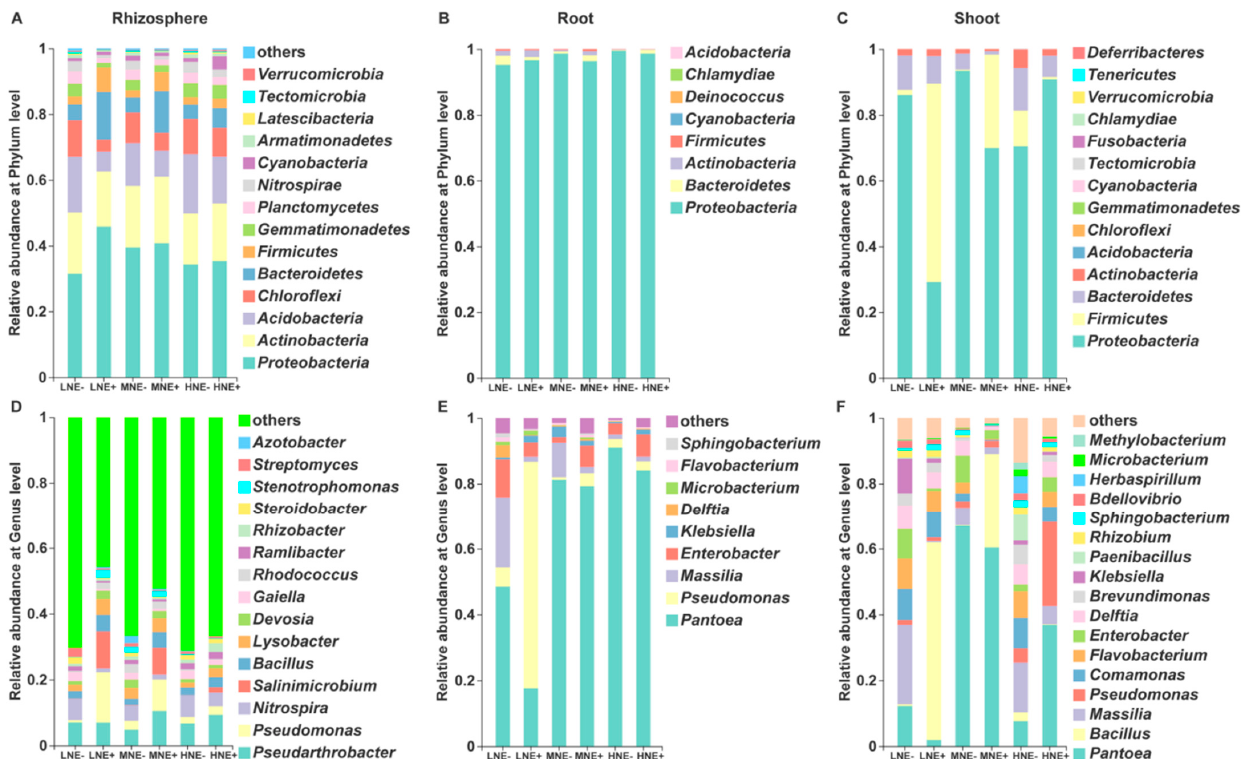
Figure 5. The composition of the bacterial communities in the rhizosphere and root/shoot endosphere at the phylum level ( A – C ) and genus level ( D – F ). LNE − : low nitrogen without inoculation; LNE+: low nitrogen with inoculation; MNE − : moderate nitrogen without inoculation; MNE+: moderate nitrogen with inoculation; HNE − : high nitrogen without inoculation; HNE+: high nitrogen with inoculation. The results were obtained based on 16s rRNA sequencing. The statistical comparison of the relative abundance of bacteria in the rhizosphere, roots and shoots at the genus level is shown in Figure S2.